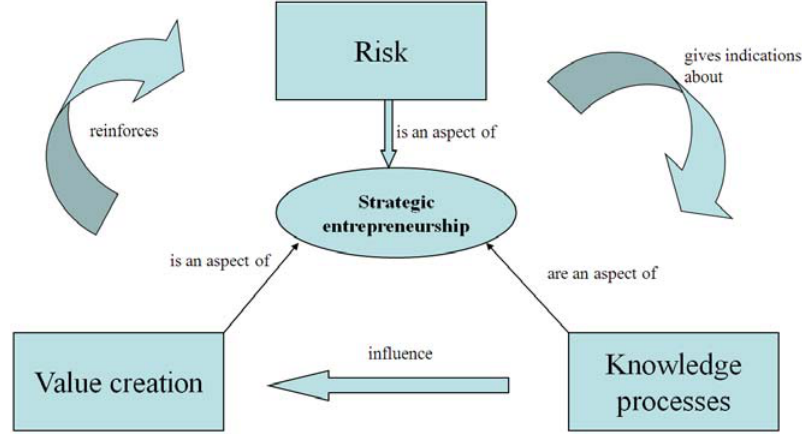
Fig. 1. Aspects of strategic